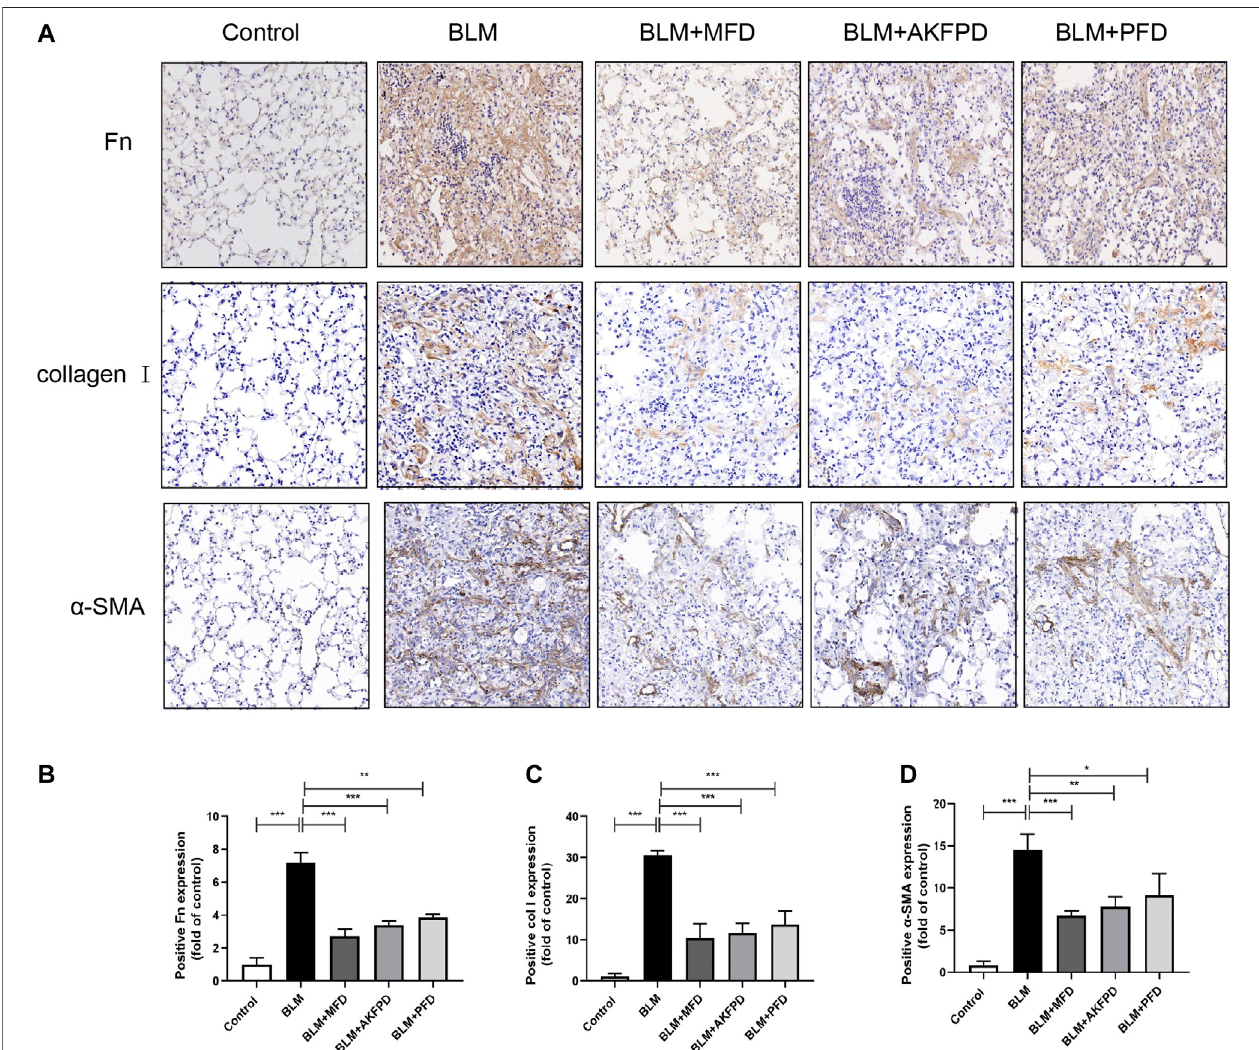
FIGURE 2 | Mefunidone inhibited the deposition of extracellular matrix. (A – D) : Representative images (A) and quantitative analysis of immunohistochemistry for fi bronectin (B) , collagen Ⅰ (C) and α -SMA (D) in lung tissues from different groups of mice. The magni fi cation in A was × 200. All data were presented as mean ± SD. ANOVA was used for comparison in (B – D) .* p < 0.05; ** p < 0.01; *** p < 0.001.